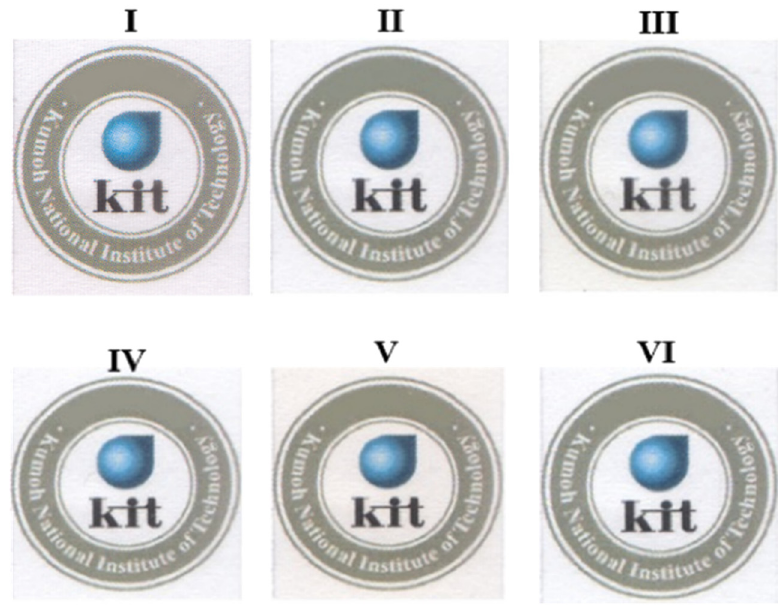
Figure 9: Photographs of the prepared CPI fi lms.